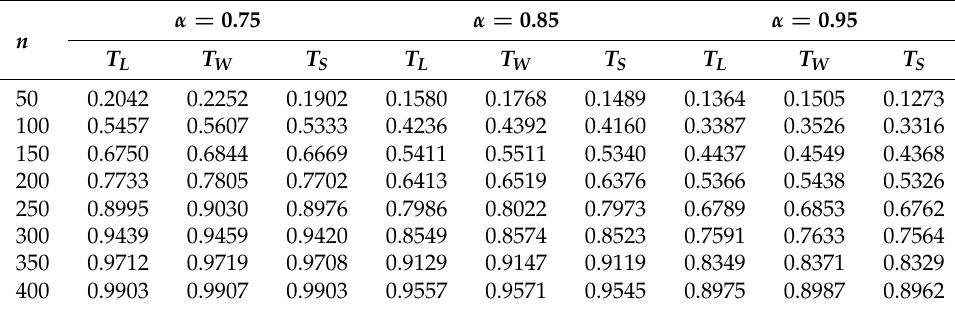
Table 4. The empirical powers of statistics ( T L , T W , T S ) for Case